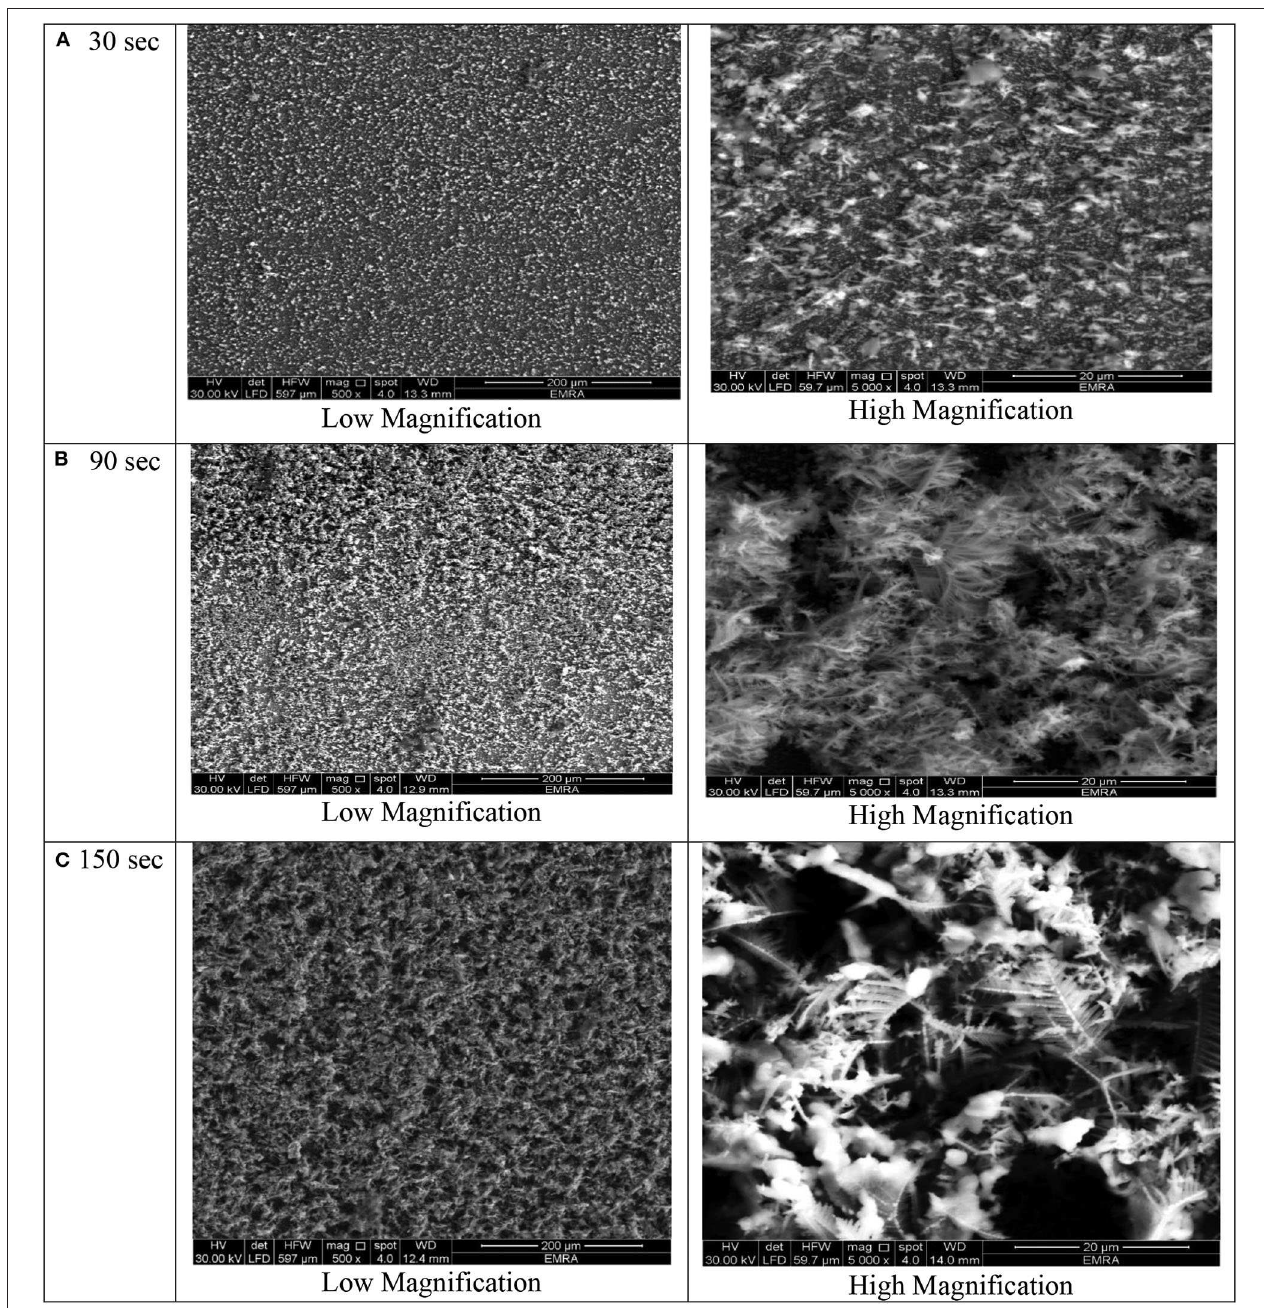
FIGURE 5 | SEM micrographs of porous Ni–Cu layers electrodeposited on AISI 304 stainless steel for (A) 30s, (B) 90s, (C) 150s at current densities of 2 mA/cm 2 .